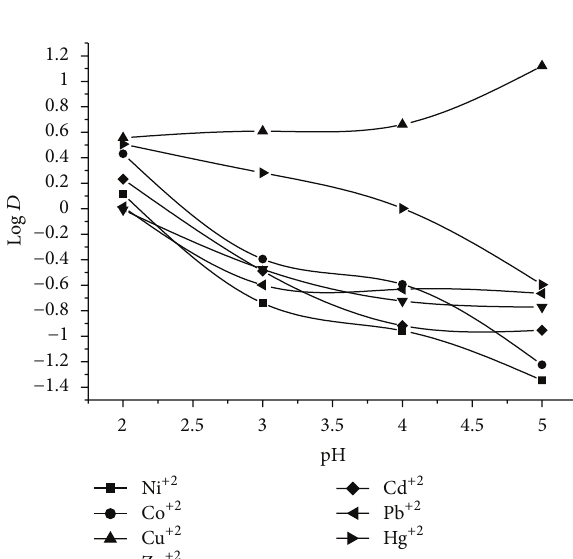
Figure 5: pH-log 𝐷 graph of L4 ligand.